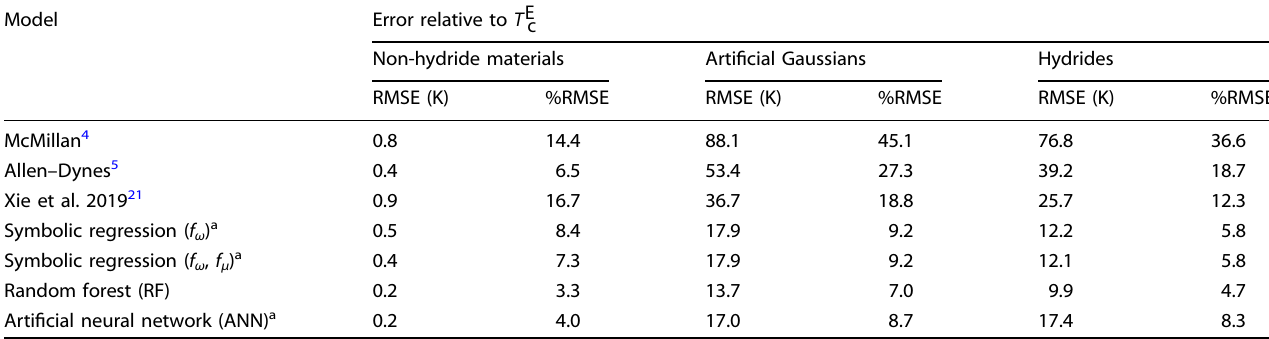
Table 3. Comparison of model performance on materials and arti fi cial Gaussian datasets. Model